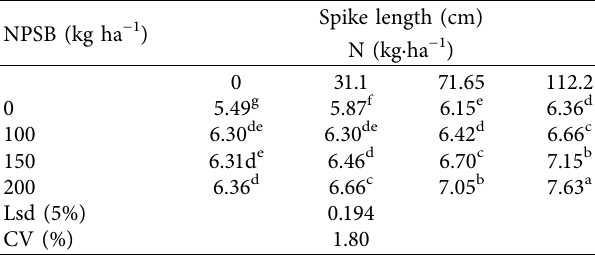
Table 4: Effects of NPSB and nitrogen fertilizer amounts on the bread wheat spike